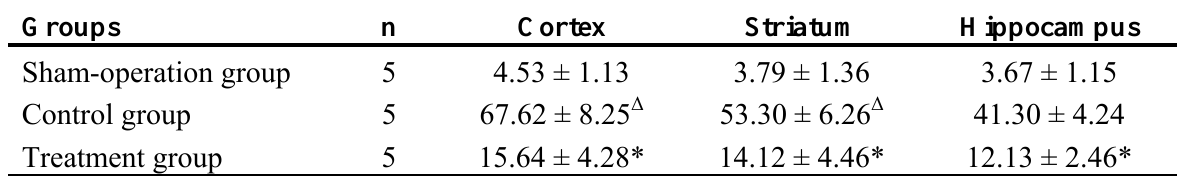
Table 2. The number of apoptotic cells in different brain regions ( x ± s).